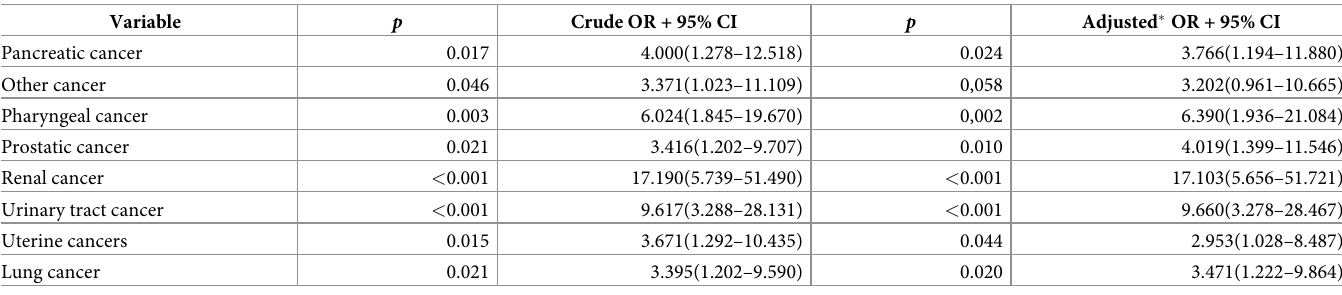
Table 4. Multiple logistic regression of cancer types for